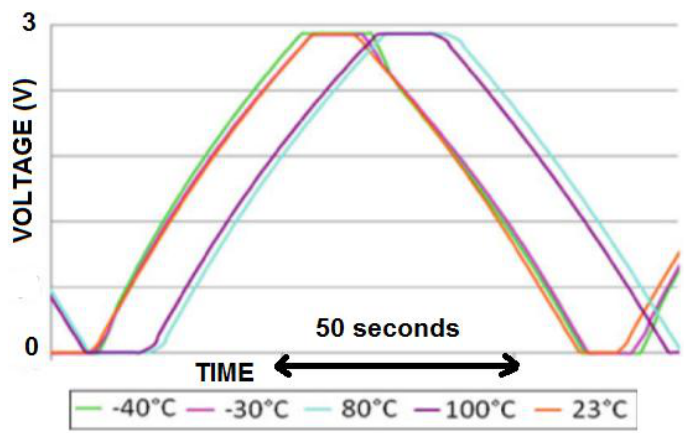
Figure 4. Thermal dependence of the voltage slope in the charge-discharge test